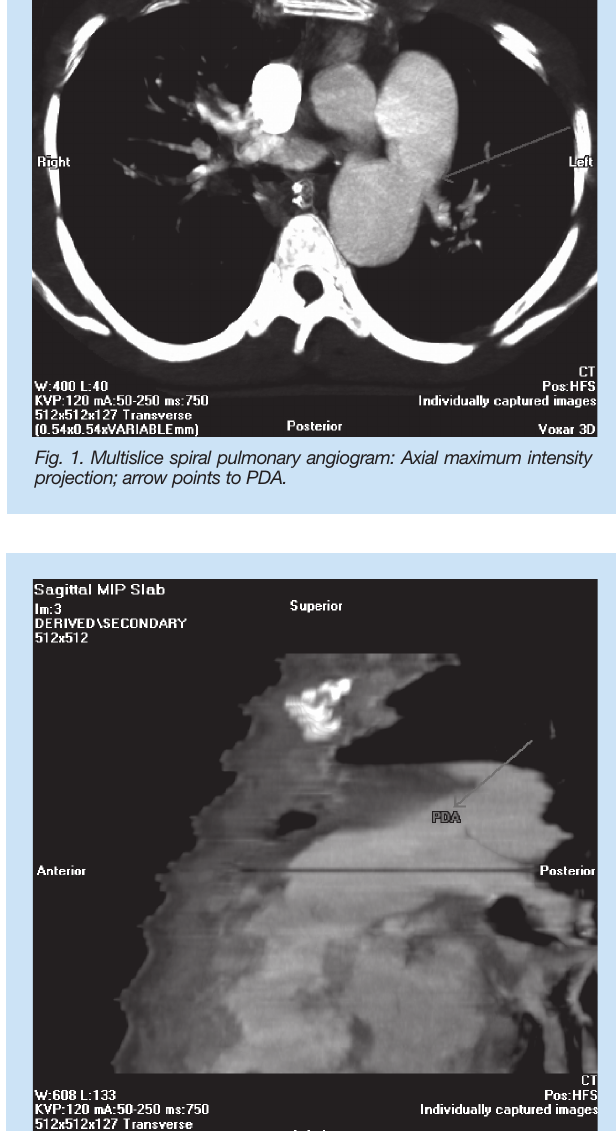
Incidental.indd